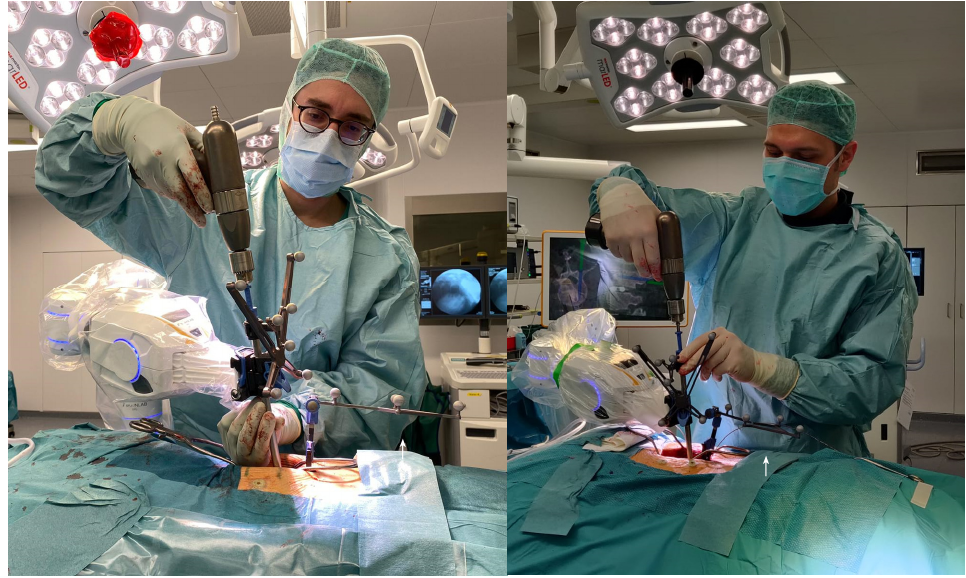
Figure 6. Position of the surgeon during the procedure. Reference array (arrow).